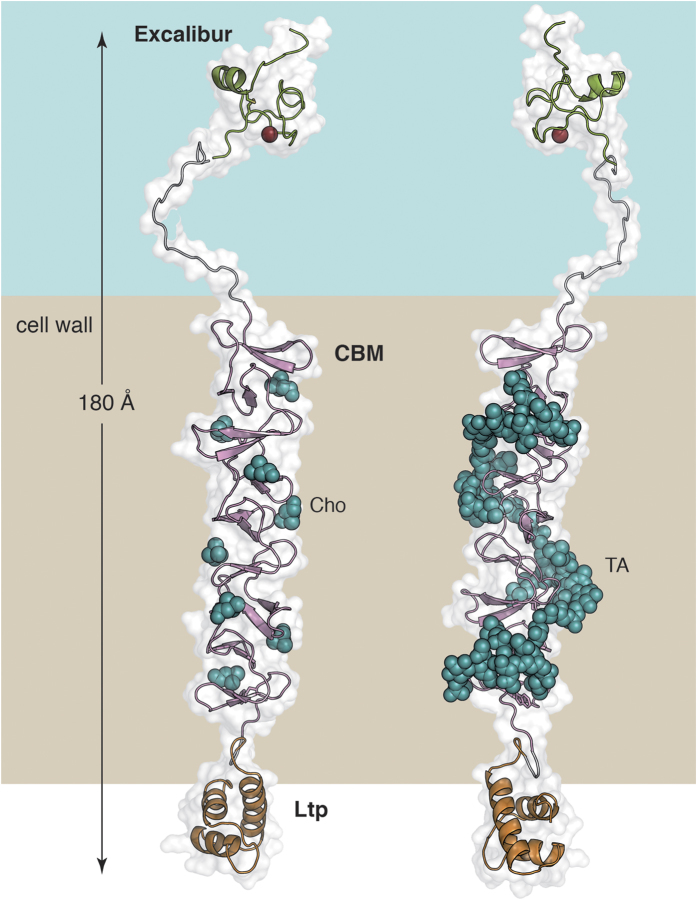
Three-dimensional model for the full-length CbpL.(Left) Each domain is colored (Excalibur in green, choline-binding module in pink and Ltp domain in orange). Disordered linkers colored in grey. Choline molecules depicted as green spheres. (Right) CbpL with a teichoic acid (green spheres) composed of four units attached. Each of the four TA units in the model is fully substituted with two phosphoryl choline moieties.